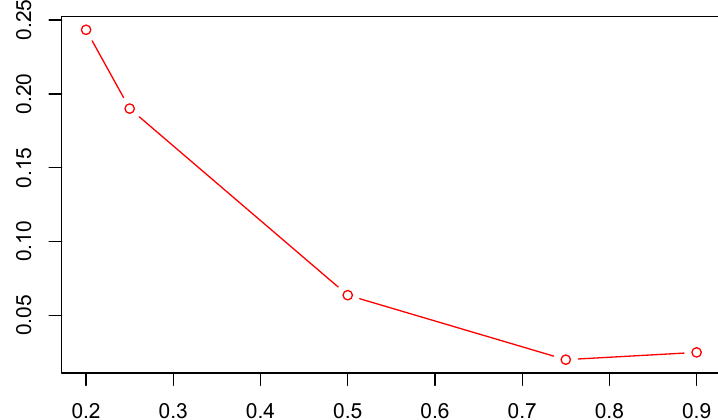
Figure 1. Approximate entropy (ApEn) of FIBM, as a function of α for N = 100. (Values of α are on the horizontal axes).